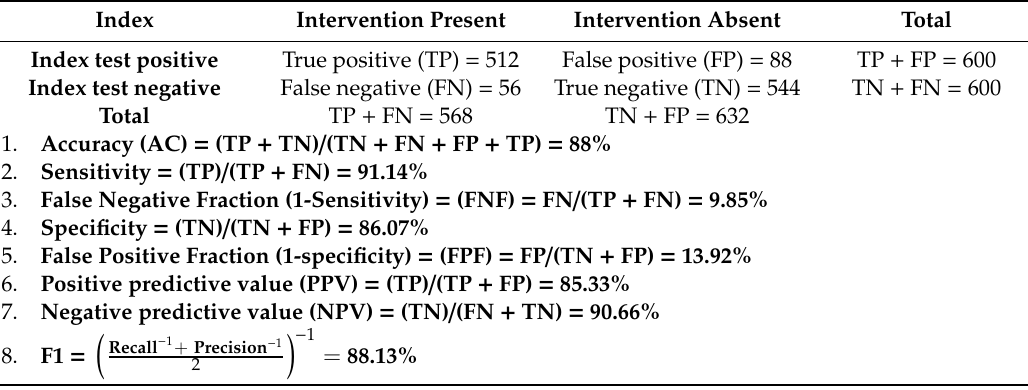
Table 15. Standard reference and results for the clinical decision support